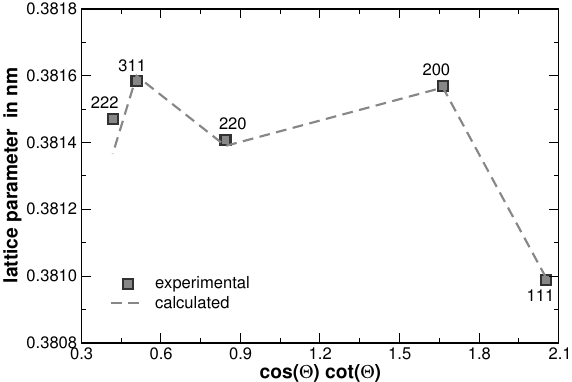
Figure 10. Cohen-Wagner plot for AuCuNiPt in the homogenized state. The corresponding diffraction pattern is shown in Figure